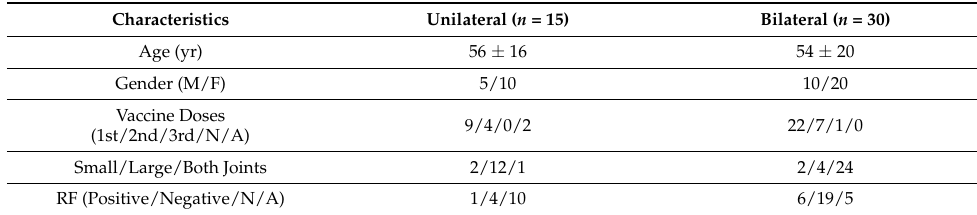
Table 2. Types of arthritis in bilateral/unilateral